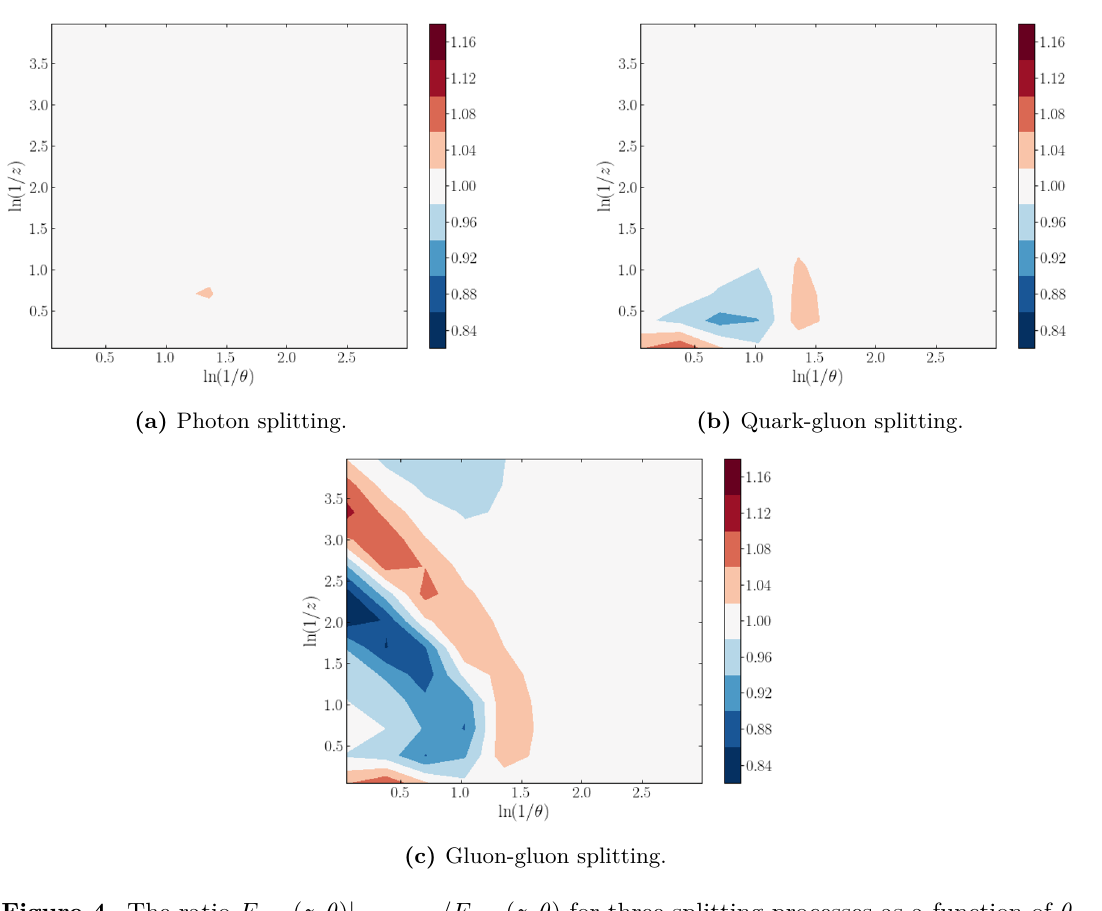
/F med ( z, θ ) for three splitting processes as a function of θ c